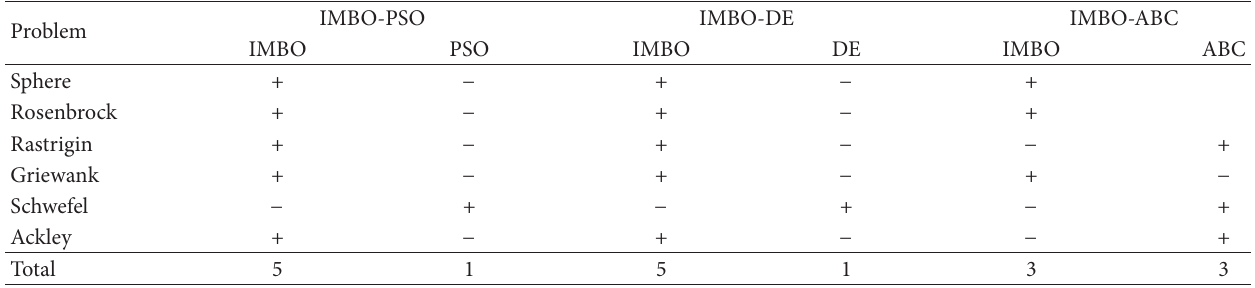
Table 12: Comparative results of IMBO with DE, PSO, and ABC algorithms over 30 independent runs for genotype size 100. + indicates that the algorithm is better while − indicates that it is worse than the other. If both algorithms show similar performance, they are both +.